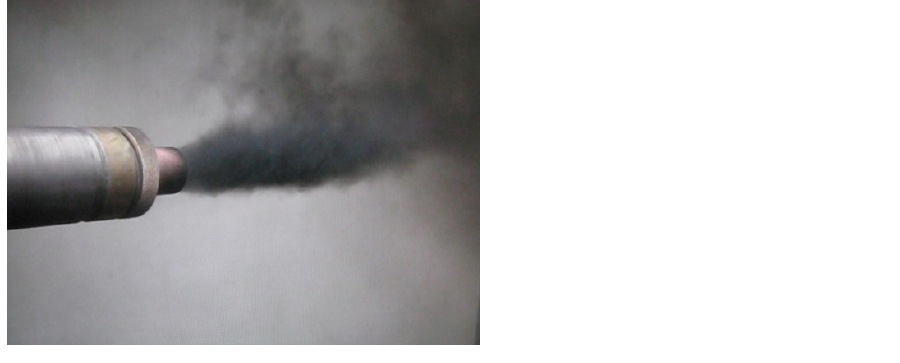
Figure 1. A shot of the pulse gas-detonation device (PGDD): nanoscale detonation carbon (NDC) is emitting from the barrel.